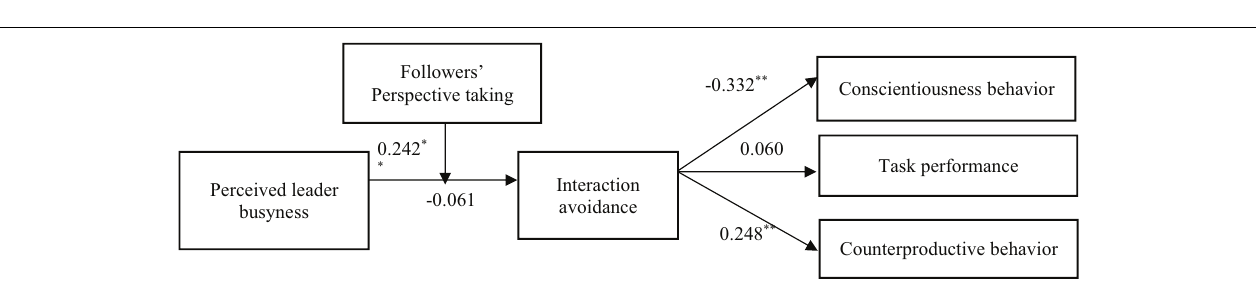
FIGURE 3 | Results of the hypothesized model. Note: N = 377, unstandardized estimates of the path coefficients, ∗ p < 0.05, ∗∗ p <